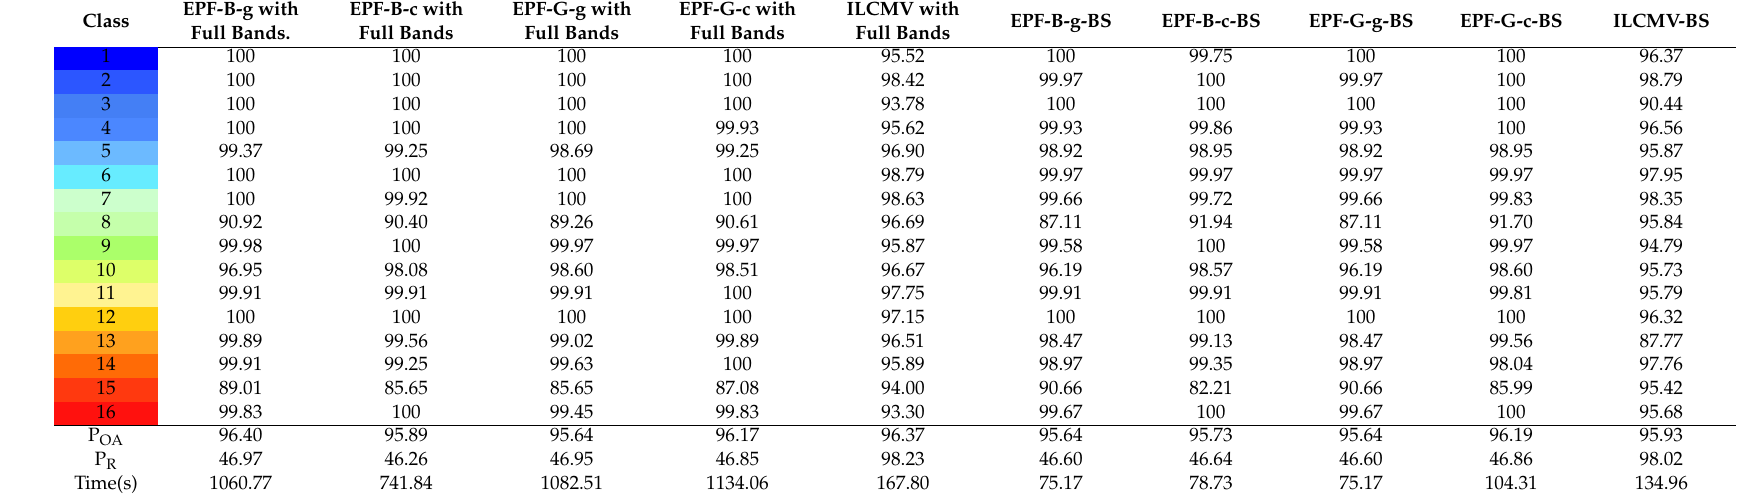
Table 10. P OA and P R calculated by the classification results using full bands and the bands selected by SQ LCMV-BSS-1 in Table 2 for Salinas. EPF-B-g with EPF-B-c with Class Full Bands. Full Bands